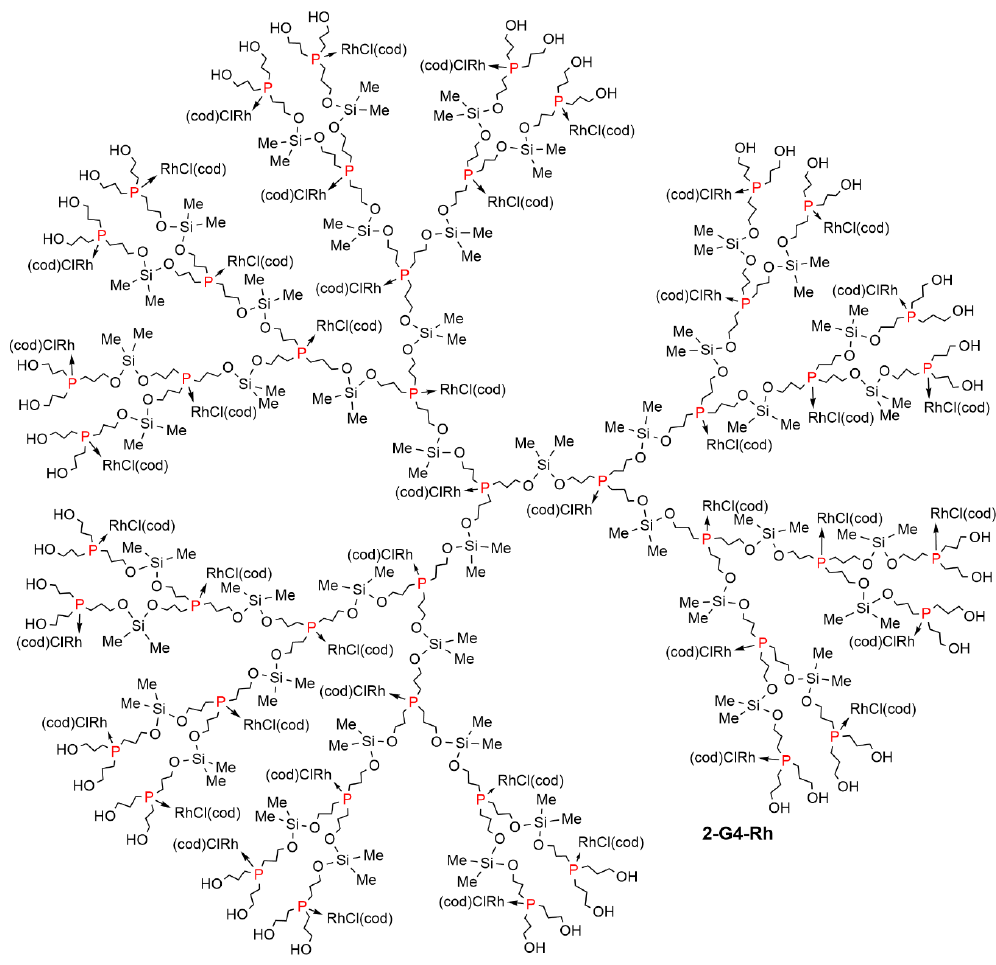
Figure 2. Full chemical structure of the dendritic complex 2-G4-Rh , synthesized as shown in Scheme 2.